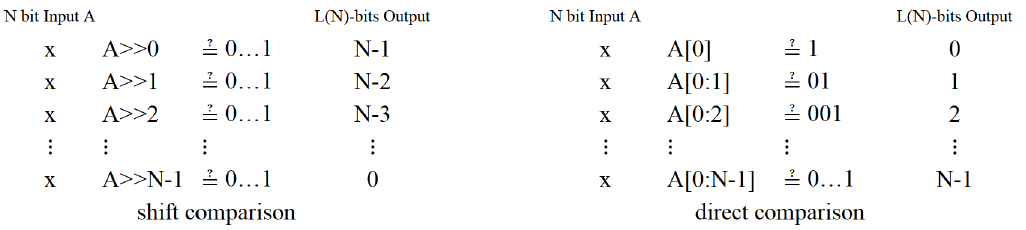
Figure 3. Two kinds of leading zeros detector (LZD).